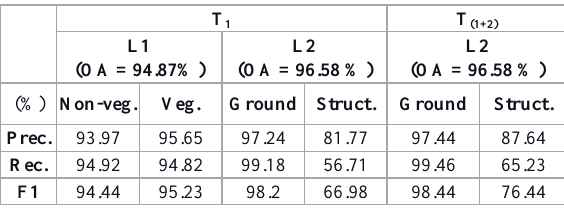
Table 2. Results achieved for Dataset_2 at the first (L1) and second (L2) levels of segmentation/generalisation. In T 1, the training set is equal to Dataset_1, while in T (1+2), T 1 is integrated with some portion of Dataset_2.